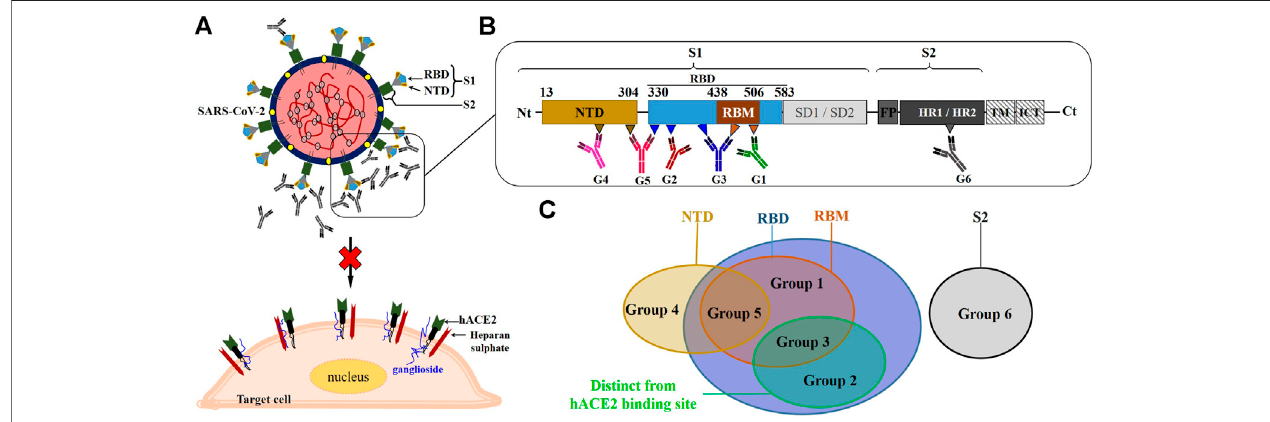
FIGURE2| Overviewoftheschematicrepresentation oftheneutralizationmechanismofNmAbsagainst SARS-CoV-2. (A) :NmAbsblockSARS-CoVbytargeting surface viral spike protein. (B) : Schematic representation of the monomeric SARS-CoV-2 spike protein and the neutralizing antibody binding fashions at their respective targetedregions (C) .NTD,N-terminaldomain;RBD,receptor-bindingdomain;RBM,receptorbinding-motif;SD1,subdomain1;SD2,subdomain2;FP,fusionpeptide; HR1, heptad repeat 1; HR2, heptad repeat 2; TM, transmembrane domain; ICT, intracellular